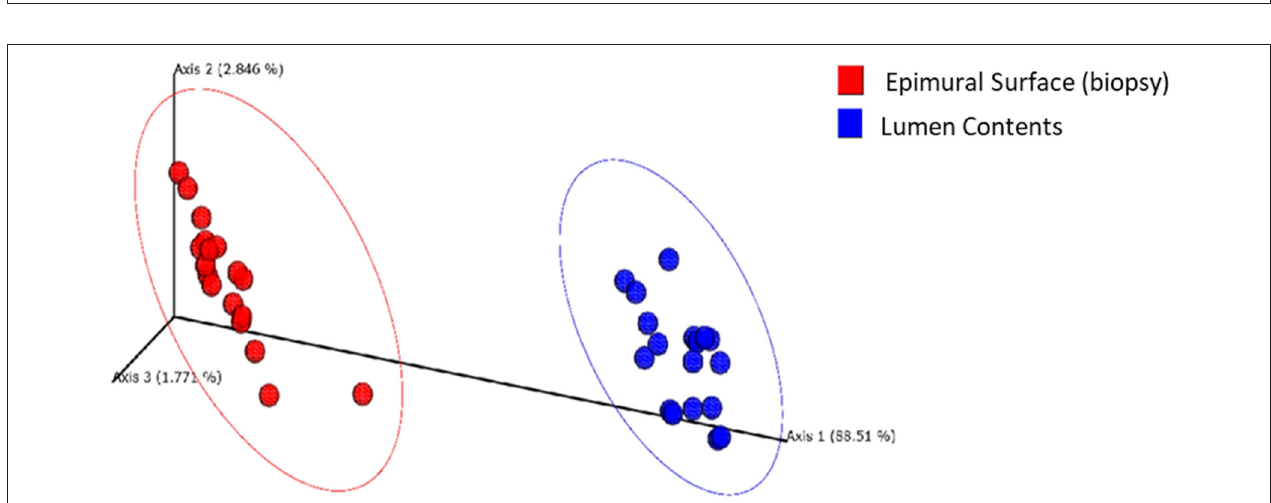
FIGURE 9 | Bacterial genus. Stacked bar chart representing the abundance of the microbiota at the genus taxonomic level in the mucosal biopsy surface and lumen contents across the sampled weeks for each animal.